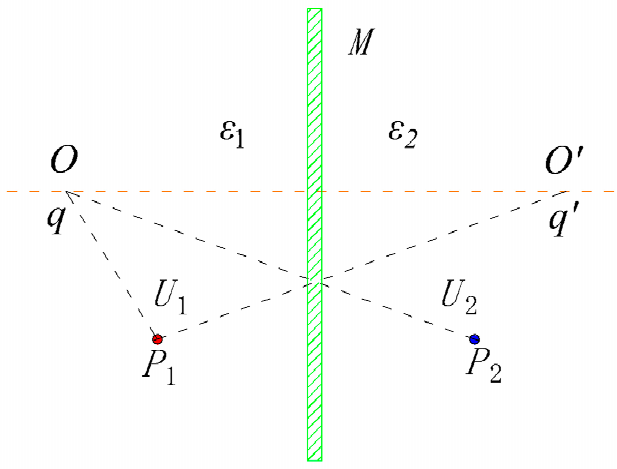
Figure 14. The sketch map of the imaging method for solving EP based on a single boundary. Where O (cid:48) and O refer to the true and imaging charges while U 1 and U 2 denote the EPs at points P 1 and P 2 , respectively.